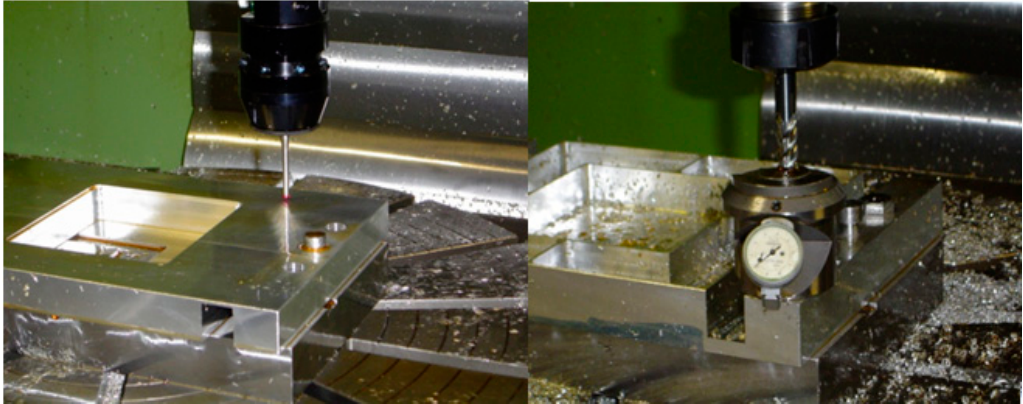
Figure 6. Measured deformation by an infrared automatic sensor.